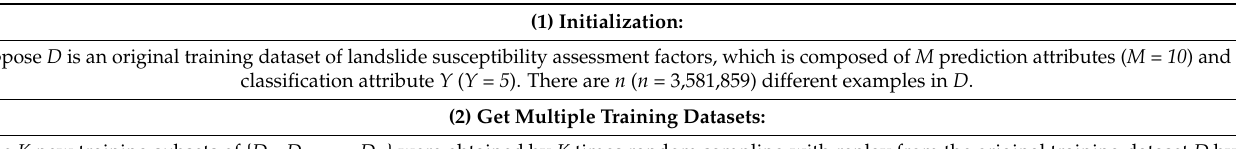
Table 3. The main steps of the random forest (RF) model.